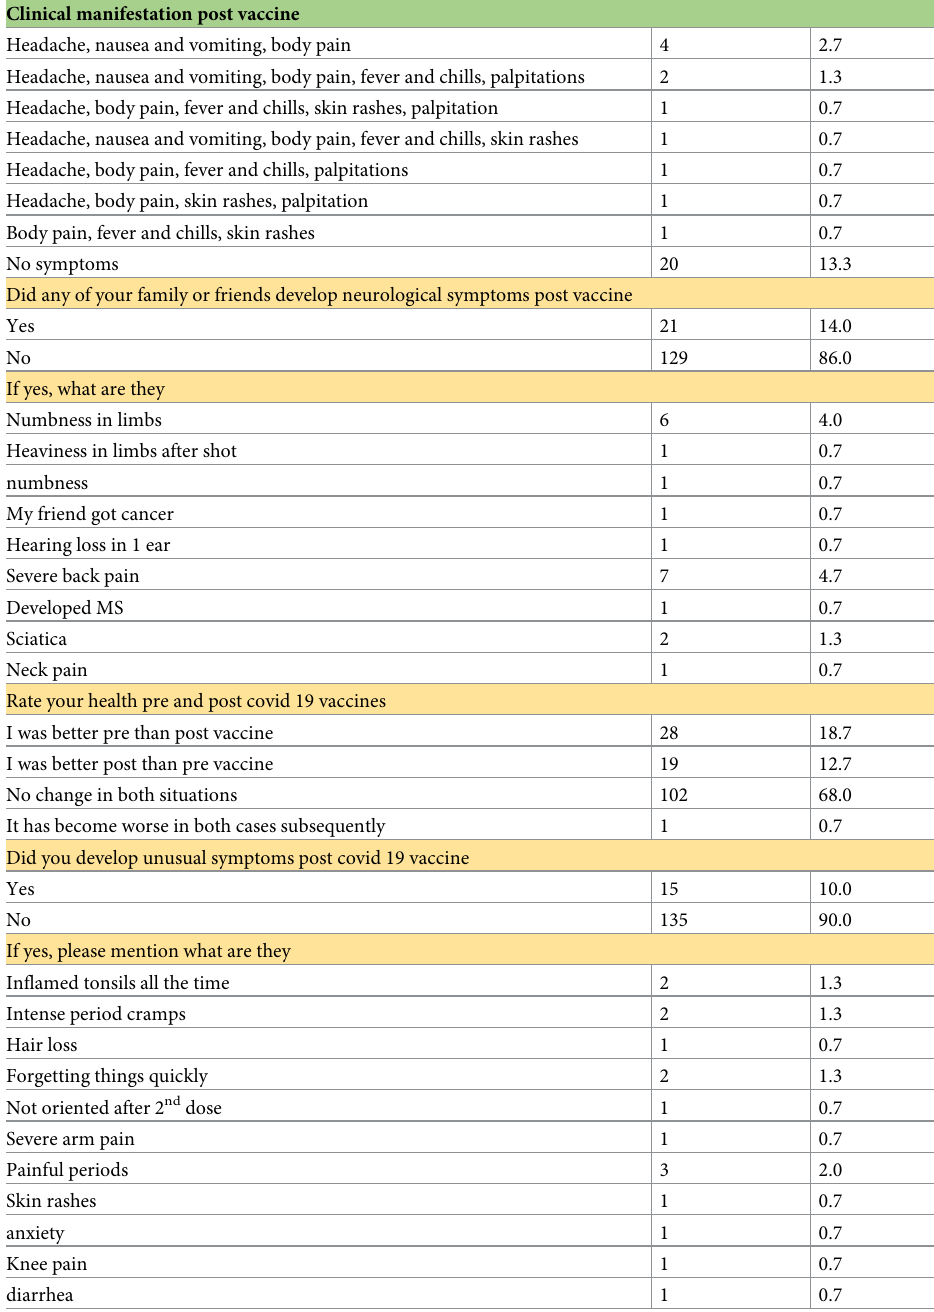
The important findings regarding reported clinical manifestation are presented in Table 5. The students were given multiple options to report their clinical manifestations post-vaccina- tion for the first and seconds dose. The most frequently reported symptoms after the first dose were “body pain” reported by 29 students (19.3%) followed by headache with body pain (n = 16,10.7%), whereas 16 students (10.7%) reported no symptoms. A similar pattern